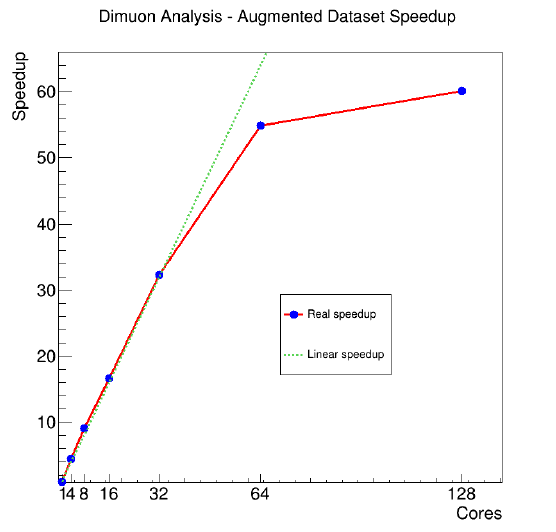
Figure 5: Speedup of the Dimuon analysis with the augmented input dataset. The green dashed line shows the ideal scaling, that is linear with the number of